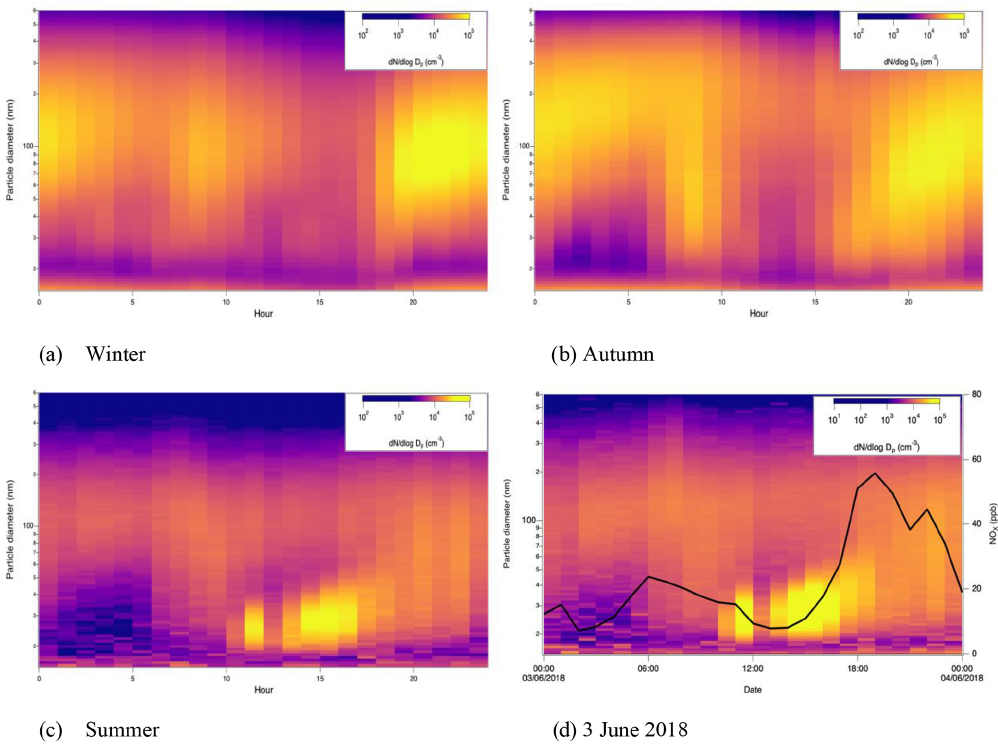
Figure 4. Diurnal contour plots for particles derived by SMPS between 15 and 660nm averaged for each season ( a – winter; b – autumn; c – summer) and for 3 June 2018 data when a new particle formation (NPF) event probably occurred (d) . The solid line shows the NO x mixing